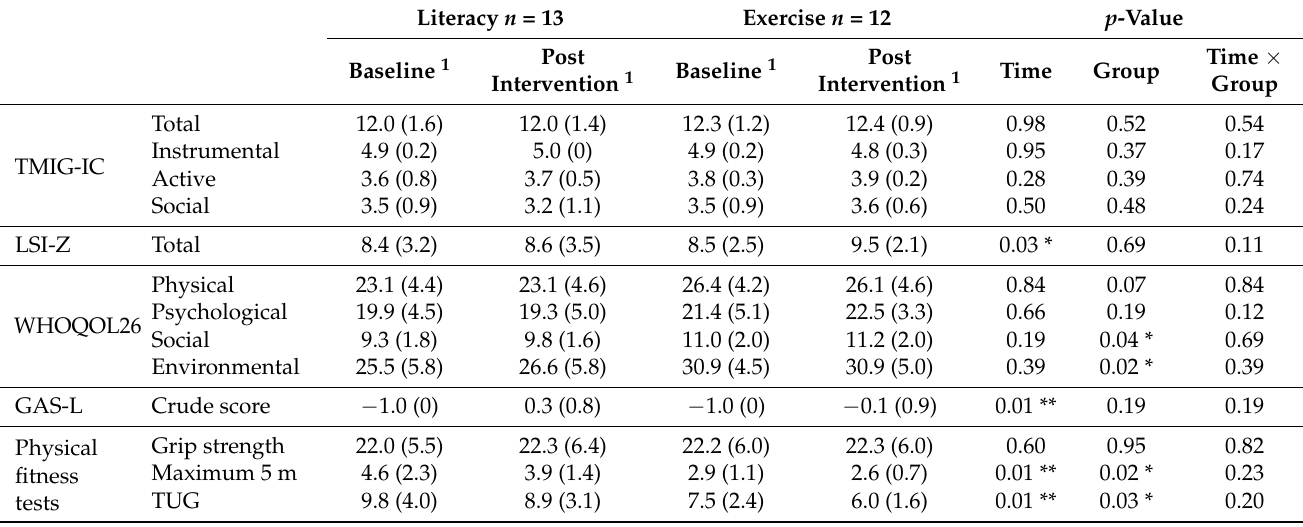
Table 3. Comparison of two factors for outcome